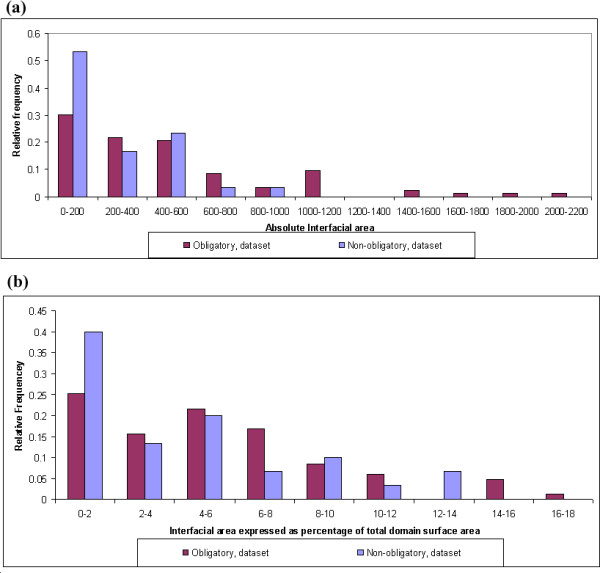
a: Distribution of the absolute interface area for obligatory and non-obligatory protein complexes in the general dataset. b: Distribution of percentage occupancy of interface for obligatory and non obligatory complexes in the general dataset.